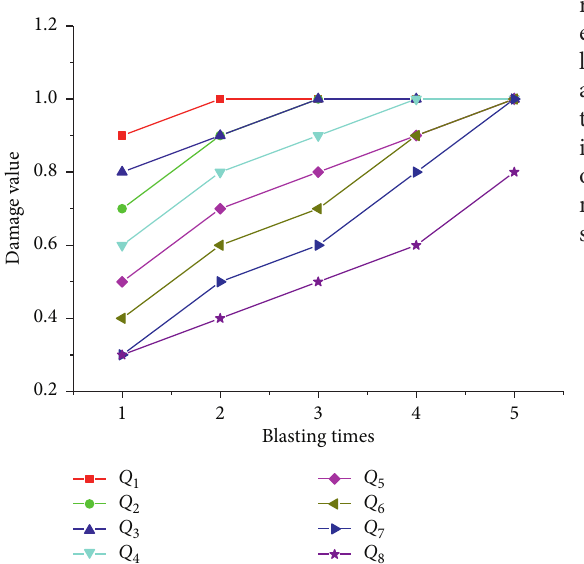
Figure 9: The curve of the relationship between cumulative damage of rock anchor beam monitoring points along the axis of powerhouse and blasting times.